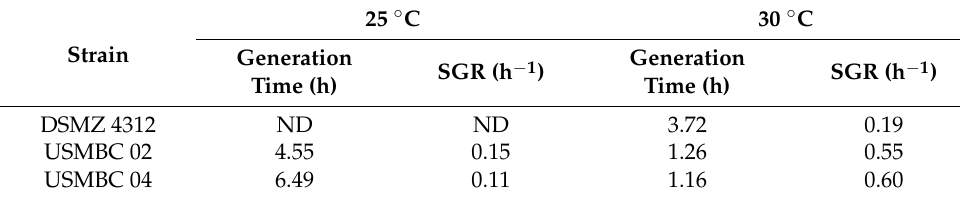
Table 3. Generation time and specific growth rate of B. cereus strains at 25 ◦ C and 30 ◦ C.